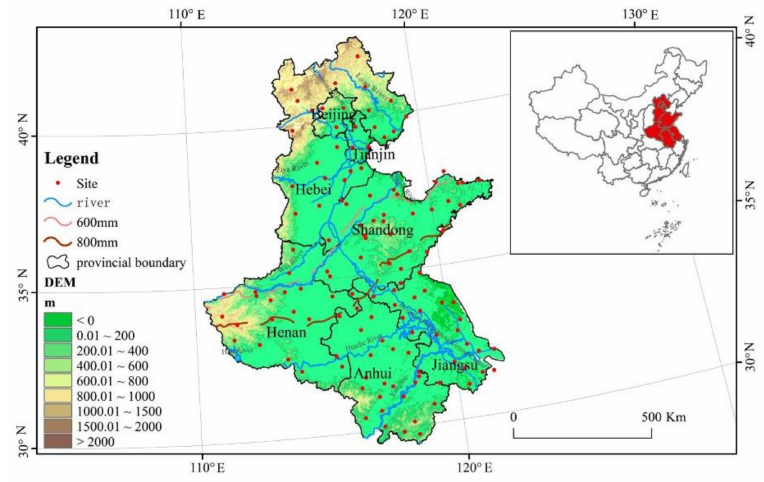
Figure 1. Study area of the North China Plain region with red dots that illustrate meteorological